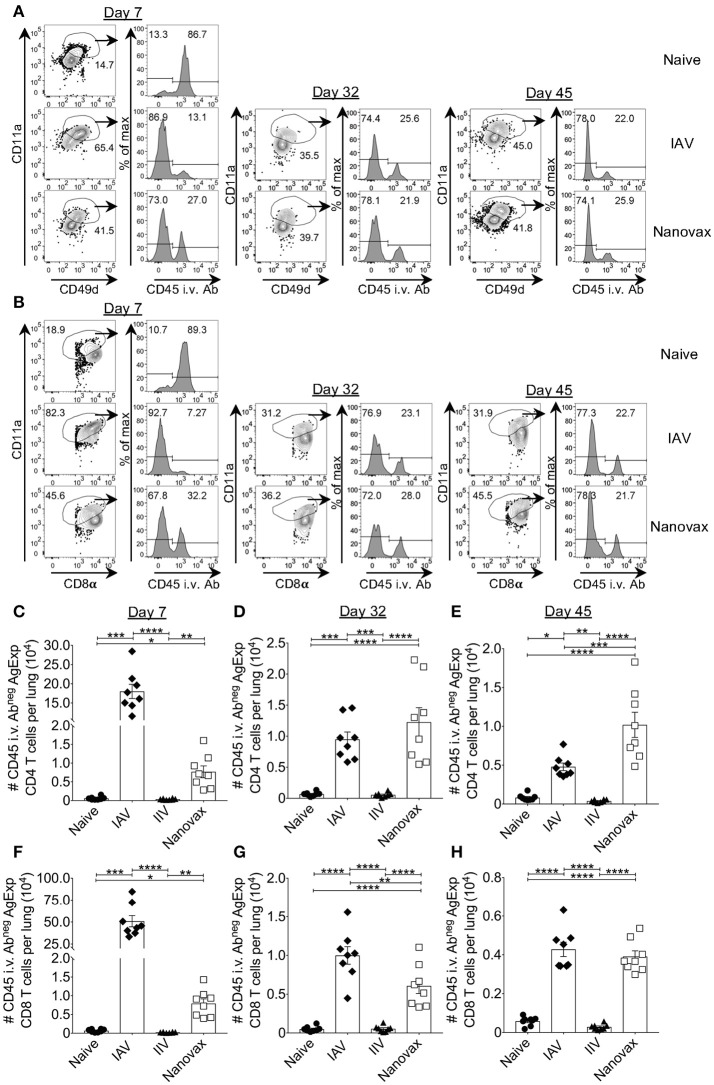
IAV-specific lung-resident CD4 and CD8 T cell responses are induced following IAV-nanovax vaccination. C57BL/6 mice were vaccinated/infected as described in Figure 1. At day 7, 32, and 45 post challenge/vaccination lungs were harvested. Representative gating strategies for (A) lung-resident AgExp CD4 T cells (CD11ahiCD49dposCD45 i.v.Abneg) and (B) lung-resident AgExp CD8 T cells (CD11ahiCD8αloCD45 i.v.Abneg). Numbers of (C–E) lung-resident AgExp CD4 and (F–H) lung-resident AgExp CD8 T cells were determined. Error bars, mean ± s.e.m. Data are from two pooled experiments with n = 8 mice. *P < 0.05, **P < 0.01, ***P < 0.001, ****P < 0.0001 (Day 7, Kruskal–Wallis ANOVA with Dunn's multiple comparisons test; Day 32 and 45, One-way ANOVA with Tukey's multiple comparisons test).